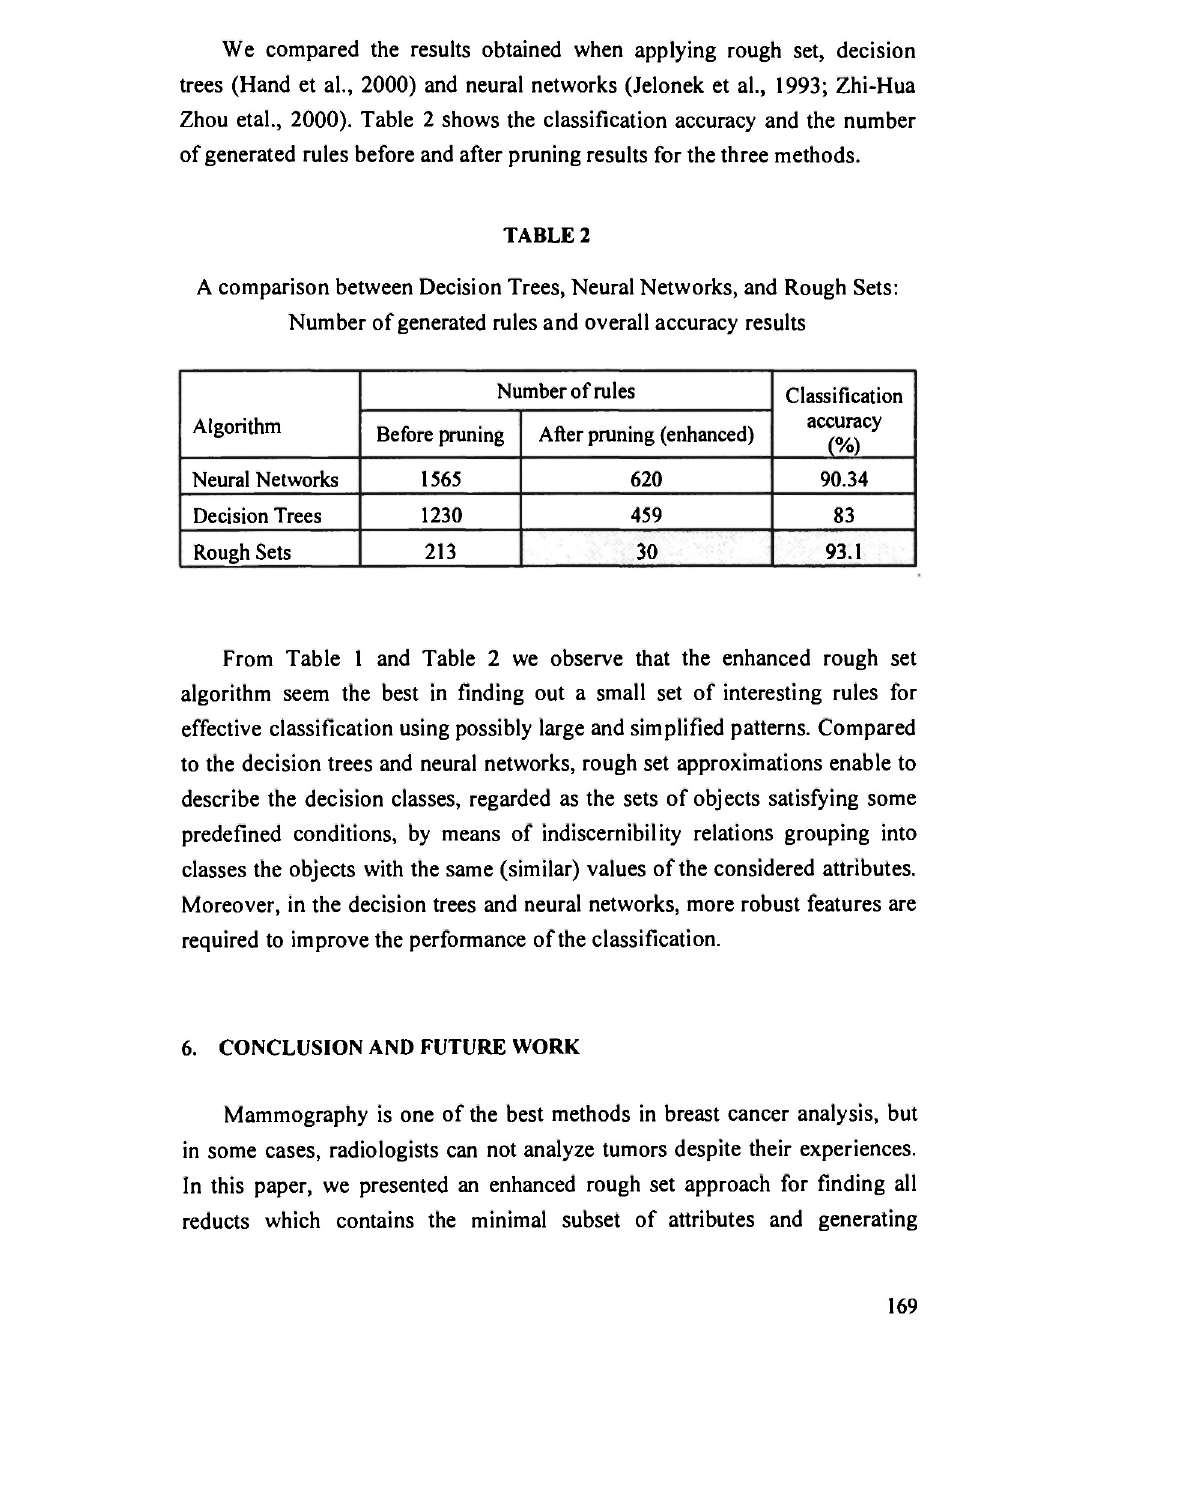
A comparison between Decision Trees, Neural Networks, and Rough Sets: Number of generated rules and overall accuracy